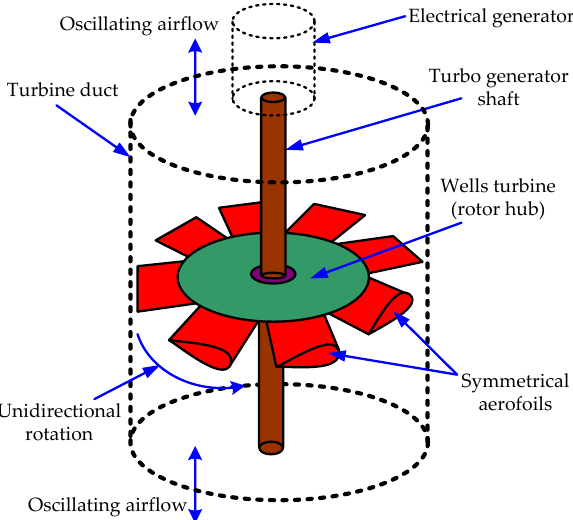
Figure 3. Schematic representation of Wells turbine.